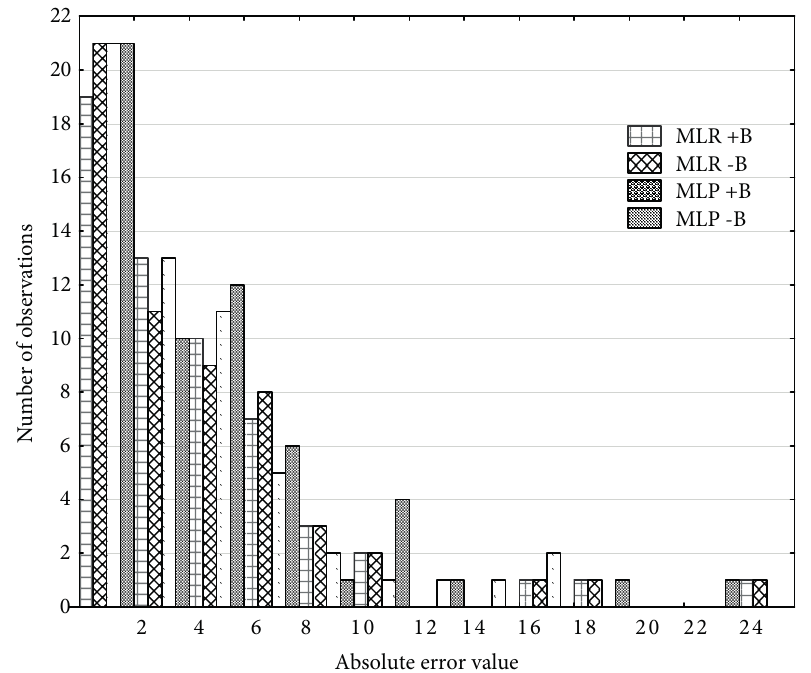
Fig. 6. Histogram of absolute errors for multi-layer perceptron (MLP) and multiple linear regression (MLR) models, with (+B) and without (–B) binary